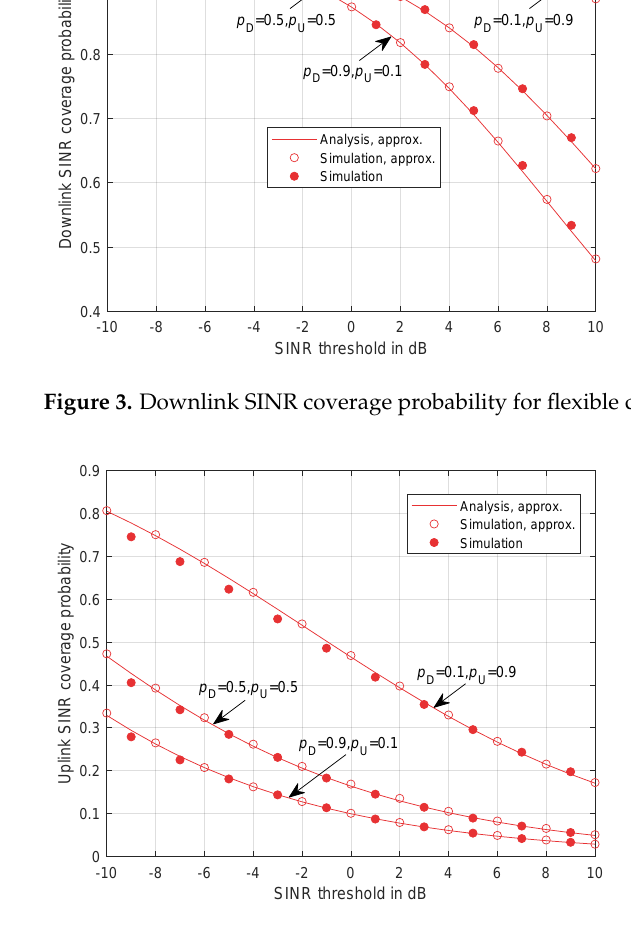
Figure 4. Uplink SINR coverage probability for flexible